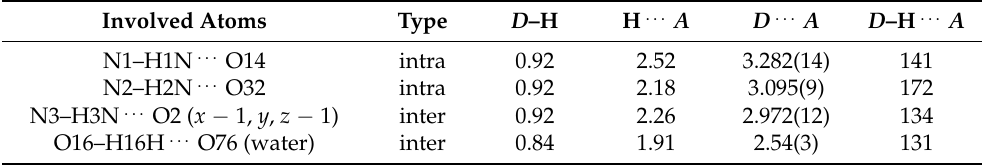
Table 3. Geometric details of selected hydrogen bonds (Å, deg.). Standard uncertainties are given in parentheses (only available for D ... A since H atoms were not freely refined). Hydrogen bond type refers to intramolecular or intermolecular hydrogen bonds. The listed hydrogen bonds are also indicated in Figure 5. Involved Atoms